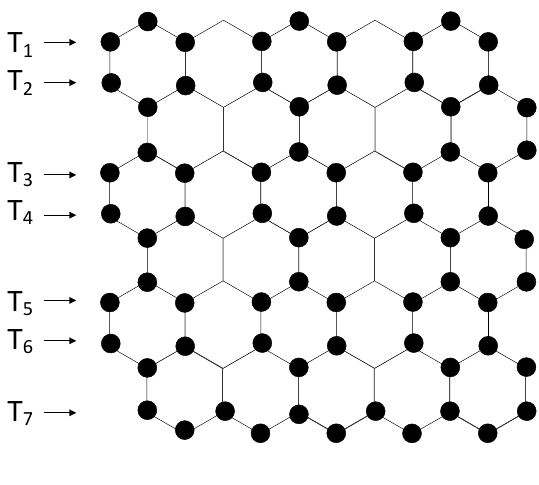
Figure 9. T 1 ∪ T 2 ∪ · · · ∪ T 7 on H 5,6